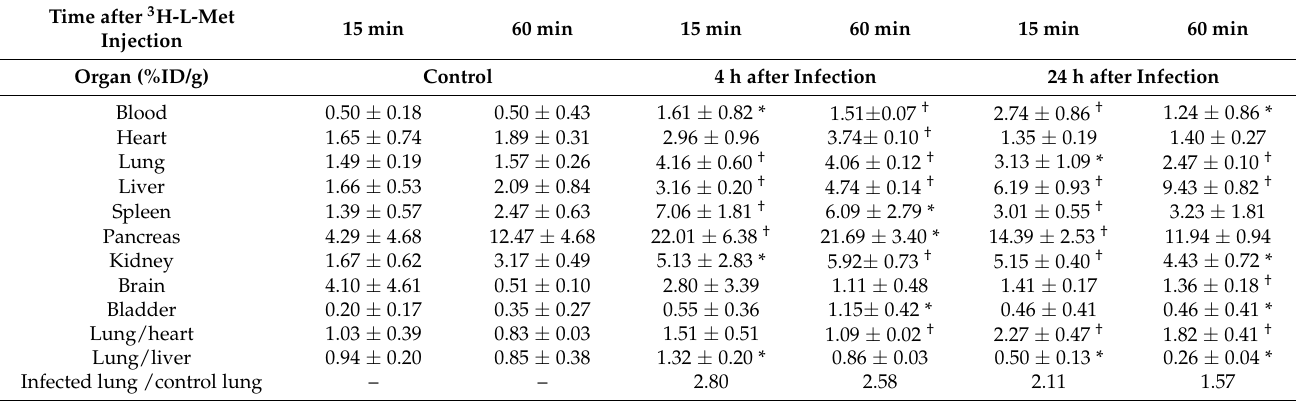
Table 1. Biological distribution of 3 H-L-Met in lung-infection-model mice.